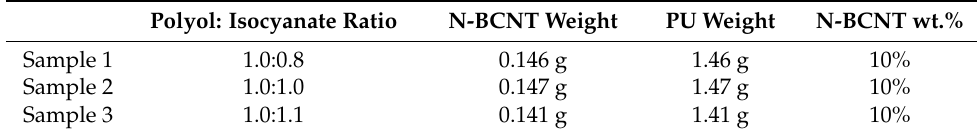
Figure 2. Schematic representation of the preparation and testing of the designed piezoresistive N-BCNT/PU sensor. ( A )—mixing N-BCNT with alcohol, ( B )—dispersion of N-BCNT in alcohol by applying sonication, ( C )—immersion of PU samples into the N-BCNT dispersion, ( D )—drying the N-BCNT/PU system, ( E )—testing the pressure sensor, ( F )—artistic picture of the pressure sensor. Table 1. N-BCNT and PU weight of the prepared N-BCNT/PU nanocomposite. Polyol: Isocyanate